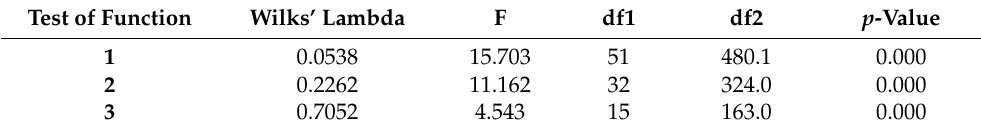
Table 1. Eigenvalues results for discriminant analysis.